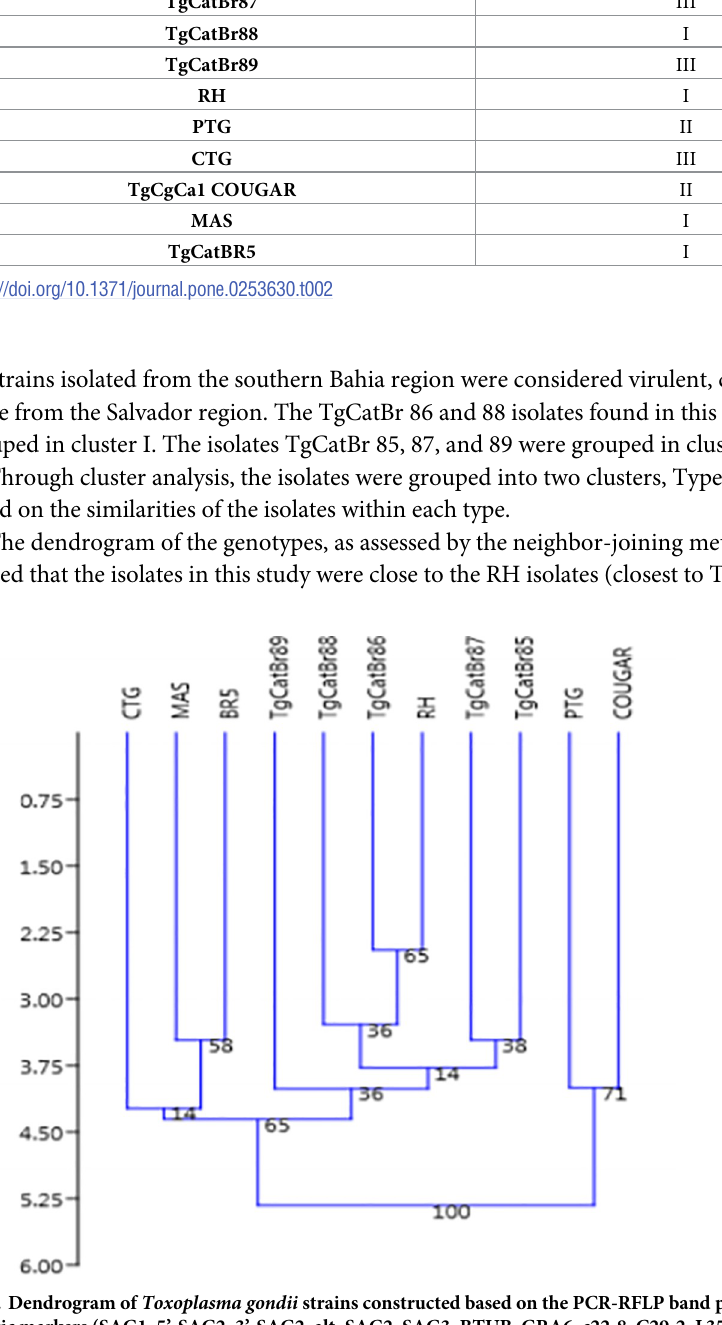
Fig 1. Dendrogram of Toxoplasma gondii strains constructed based on the PCR-RFLP band patterns using eleven genetic markers (SAG1, 5’-SAG2, 3’-SAG2, alt. SAG2, SAG3, BTUB, GRA6, c22-8, C29-2, L358, PK1, Apico and CS3). The tree was built using the neighbor-joining method for clustering after bootstrapping with 10,000 repetitions, and the distances were calculated using the Dice method.